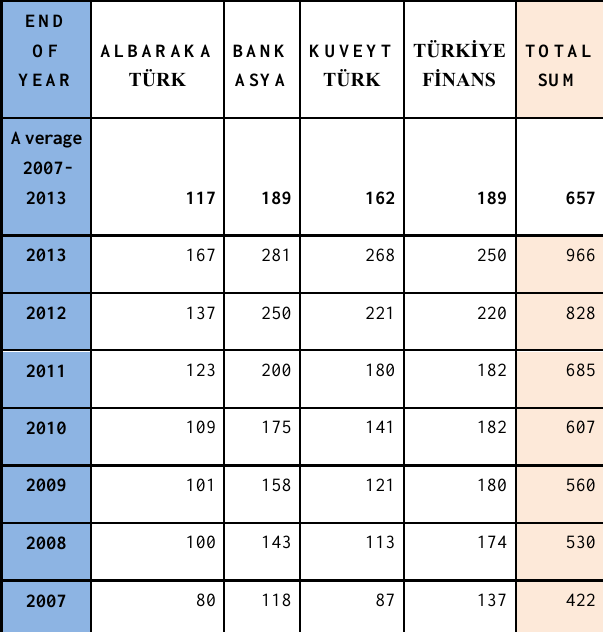
Table-3/a: Growth of Branch Numbers,